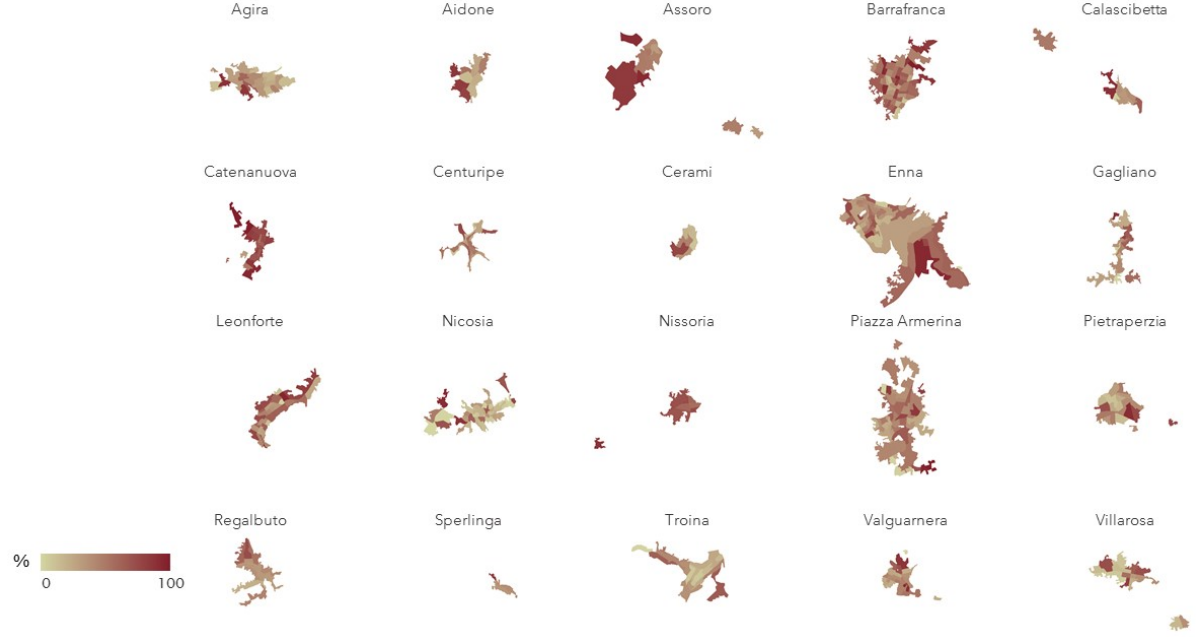
Figure 8. Map of the concentration of the rented households rate on the scale of the Census Sections in the 20 towns of the Enna Province. The darker brown area indicates the maximum value.